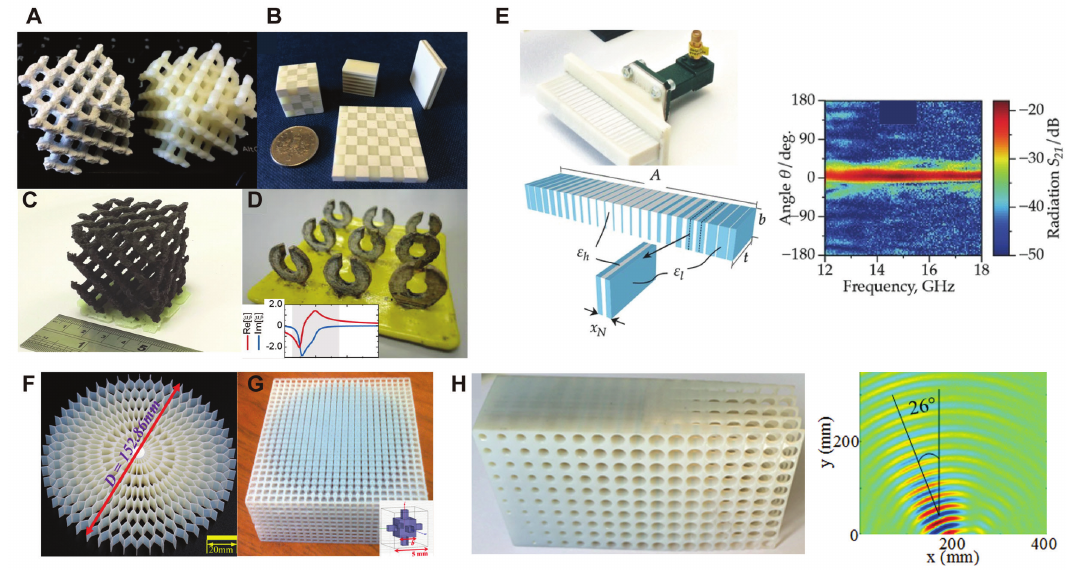
Figure 8: 3D printing for microwave metamaterials and transformation optics. (A) Diamond-like lattice composed of ABS only (right) and ABS + BaTiO composite (left). (B) Samples composed of alternating areas of ABS 3 and ABS + BaTiO that are printed using a dual-extrusion nozzle. (C) Diamond-like lattice made of ABS with a 10 vol% NiZn ferrite filament. 3 Adapted from Ref. [98]. Copyright (2015) The Royal Society Publishing. (D) PLA-SRRs sample after selective electroless plating on an ABS structure (inset: anti-resonant dispersion for bi-anisotropy). Adapted from Ref. [99]. Copyright (2017) AIP Publishing. (E) Left: Schematic of a GRIN lens with low (blue) and high (white) relative permittivity regions and photograph of the short horn with 3D-printed GRIN lens. Right: Experimental radiation pattern of the GRIN lens. Adapted from Ref. [100]. Copyright (2016) John Wiley & Sons (F) Photograph of a 3D-printed planar Luneberg lens. Adapted from Ref. [101]. Copyright (2018) ACS Publications. (G) 3D-printed Luneburg lens antenna (inset: schematic of the cubic-unit cell). Adapted from Ref. [102]. Copyright (2014) IEEE. (H) Photograph of a 3D-printed beam steering lens and the measured electric field distribution for the lens antenna. Adapted from Ref. [103]. Copyright (2016) IOP